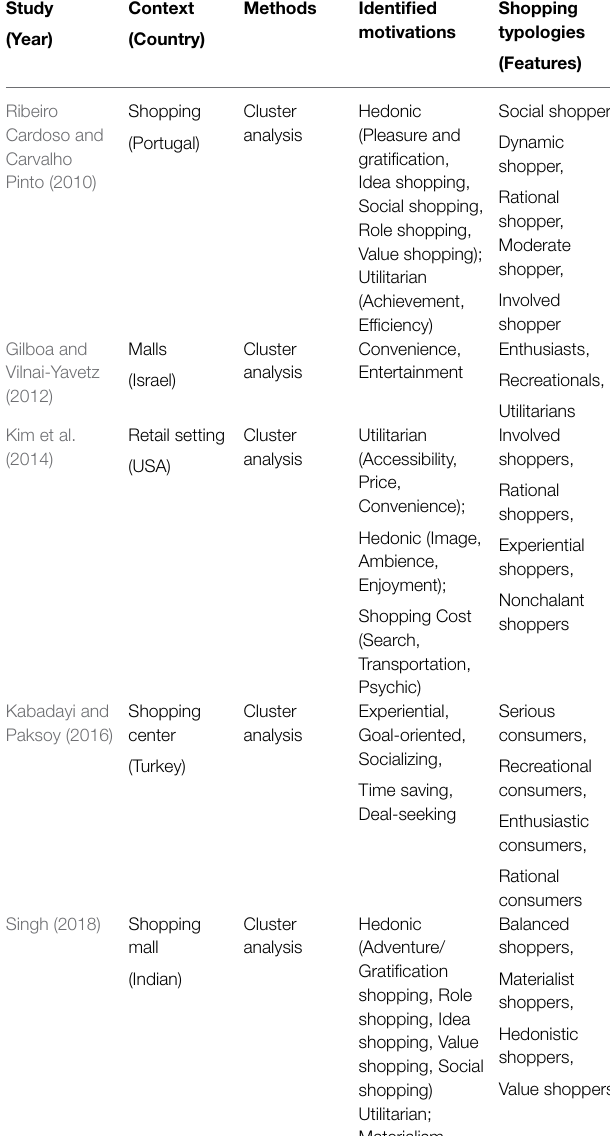
TABLE 1 | A review of recent consumer motivations typologies studies across